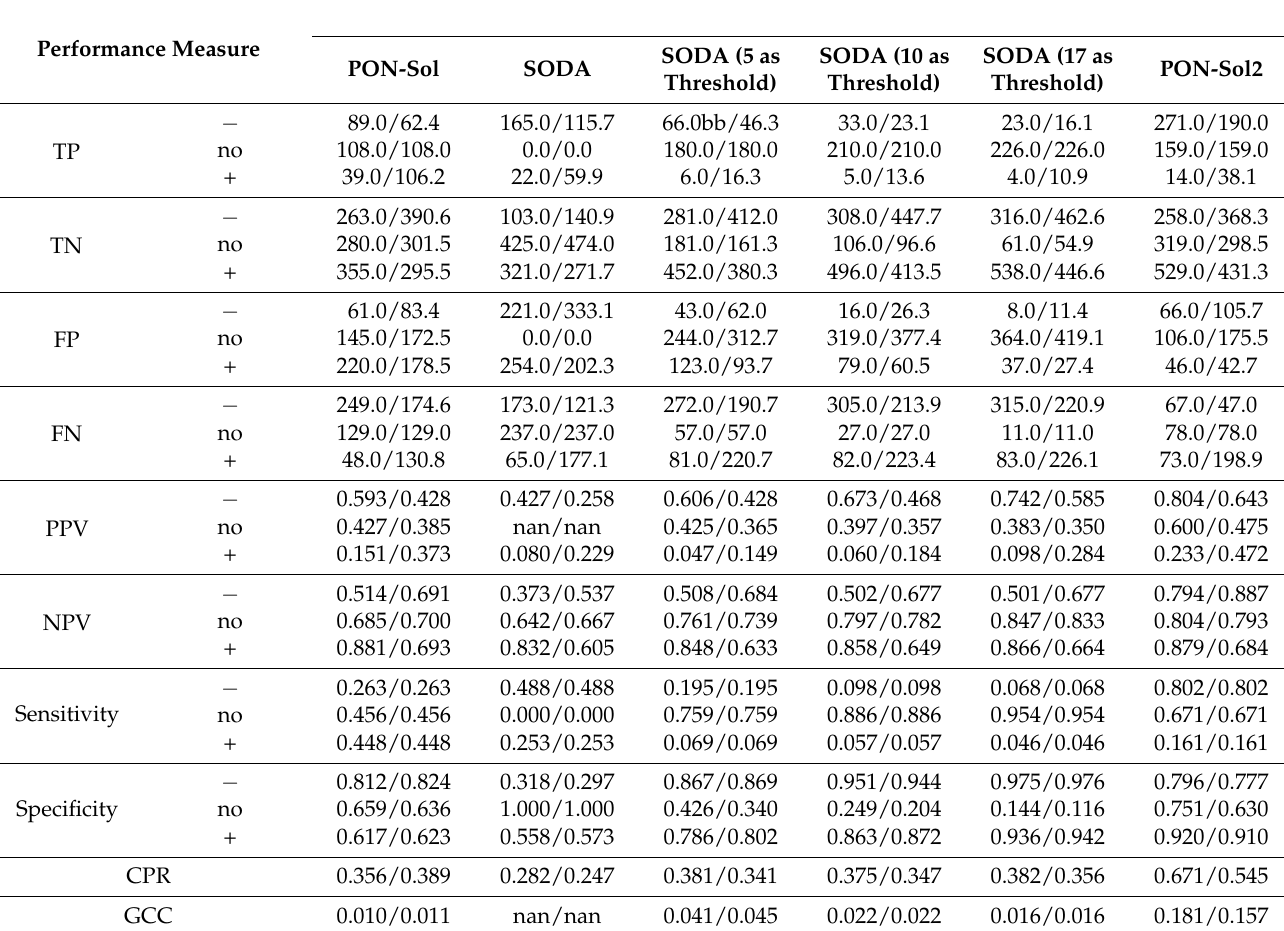
Table 6. Comparison of the prediction performance of PON-Sol2 with SODA and